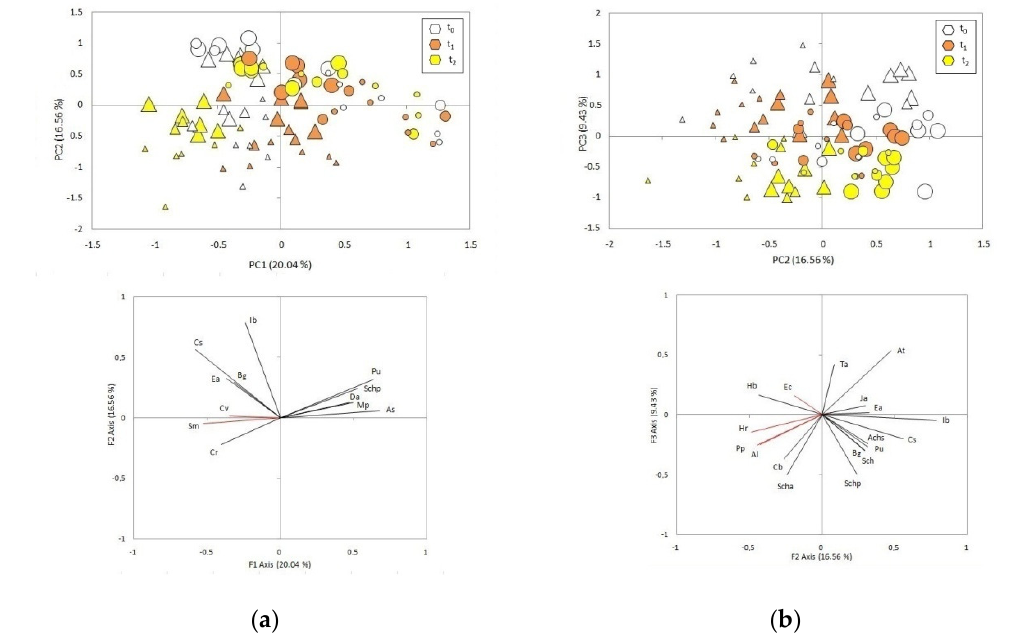
Figure 2. Principal Component Analysis (PCA) of sampling units of different sizes and at different times in relation to fire, located in continuous grassland (circles) and surrounded by a pine plantation (triangles), and vectors of plant species with the abbreviations of the names (see references in Table S1; exotic species in red). ( a ) PC1 and PC2, ( b ) PC2 and PC3. Symbols of different sizes represent sample units of different areas (small = up to 0.1 ha; medium = 0.1 to 0.5 ha; large = 0.5 to 2.5 ha) and colors represent different times: before the fire (t 0 , white), and three (t 1 , orange) and fifteen months (t 2 , yellow) after the fire. Table 1. MANOVA